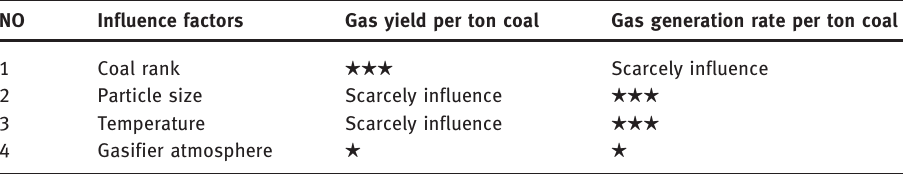
Table 4: Influence factors on the gas generation behaviour of lump